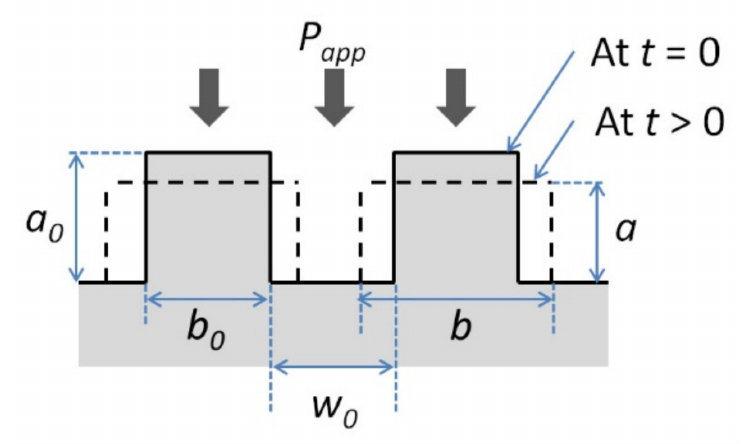
Figure 5. Simplified surface representation used by Lee and Springer for their intimate contact